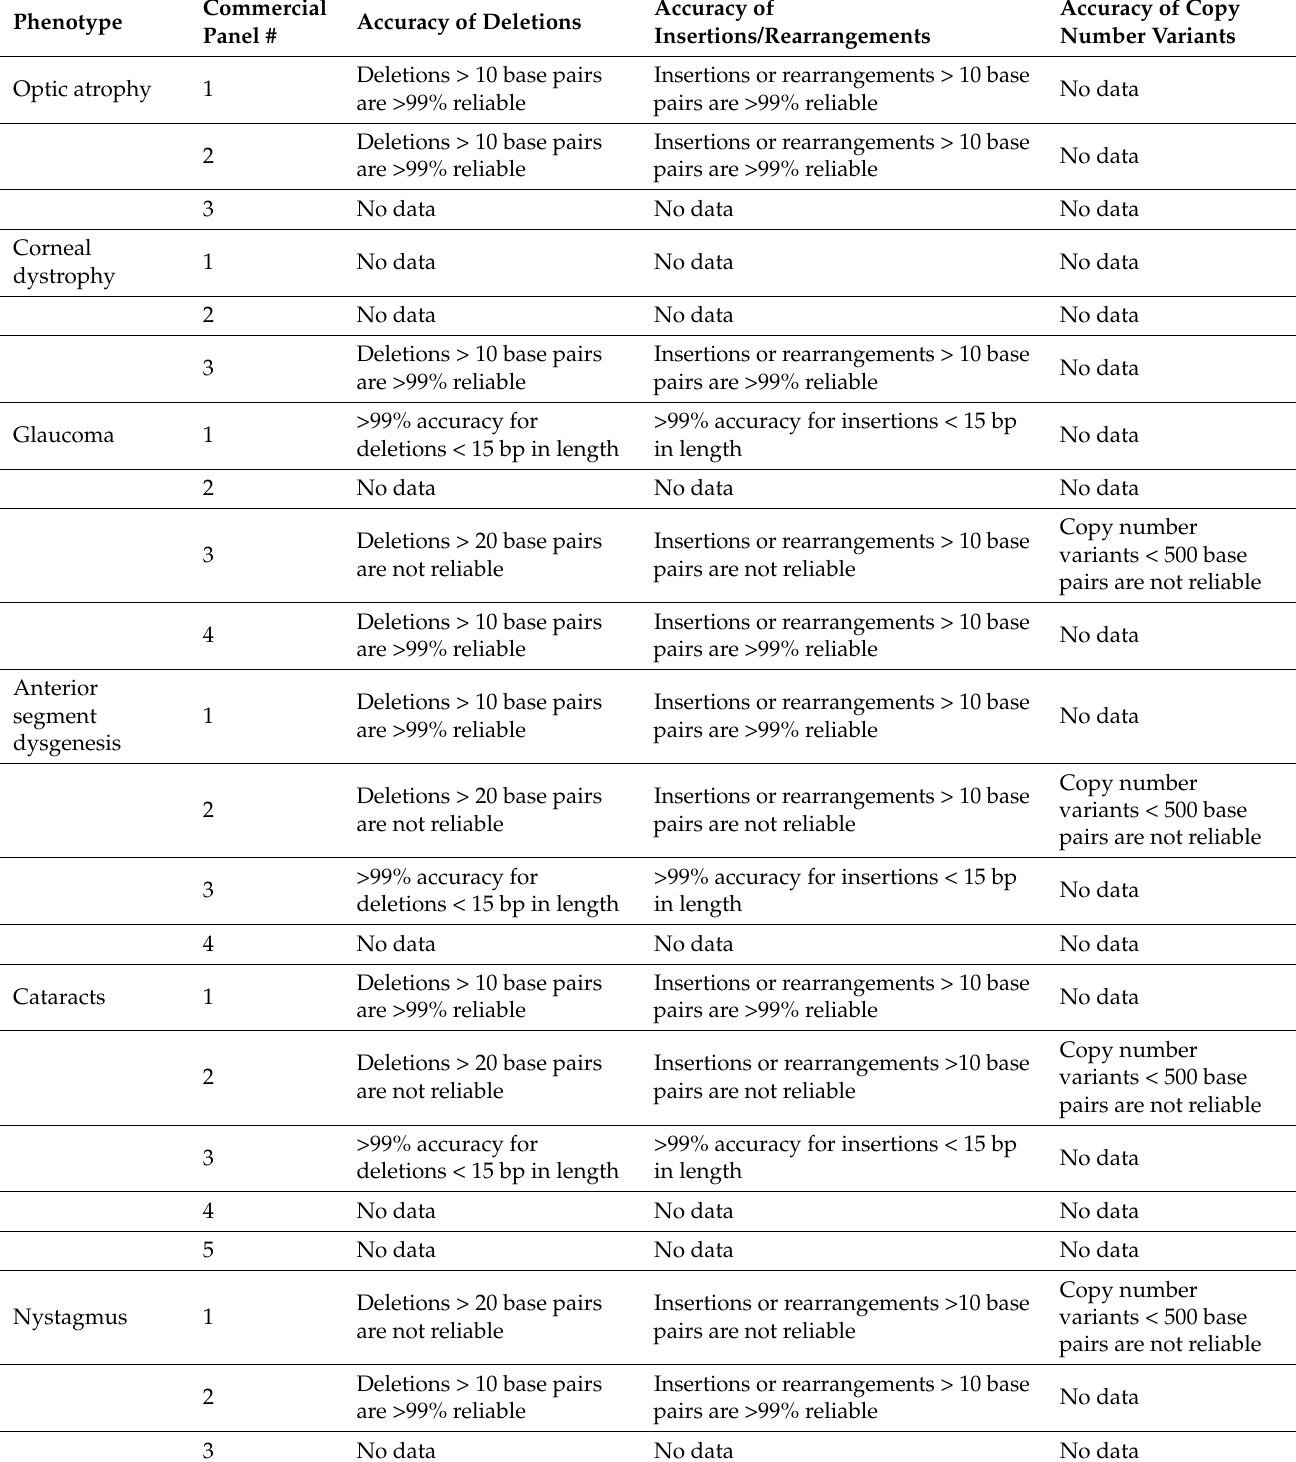
Table 2. Panel accuracy for Deletions, Insertions, Rearrangements, Copy Number